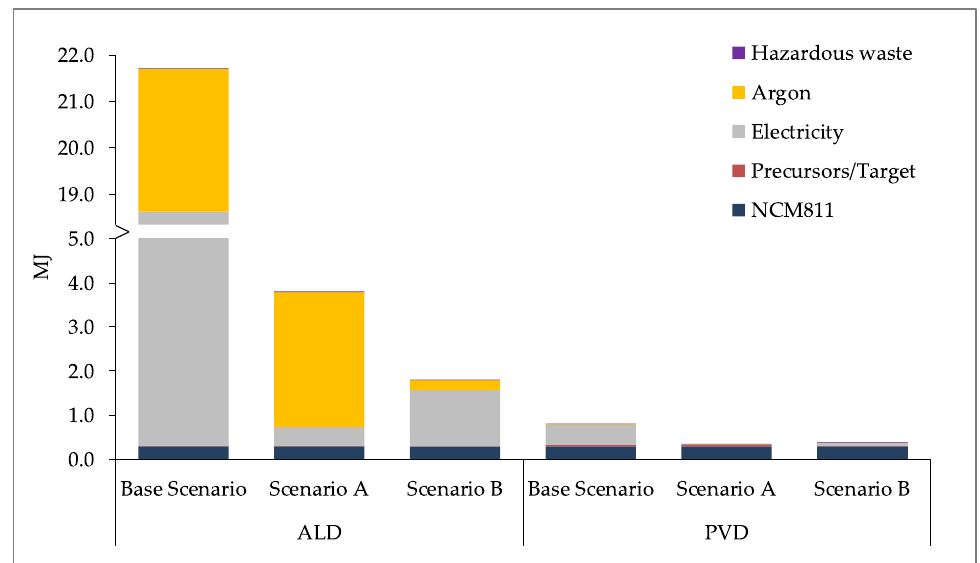
Figure 9. LCIA Results of the Scenario Analysis per 1 g of Input NCM811 for the Energy Resources (fossil, non-renewables) Impact Category.